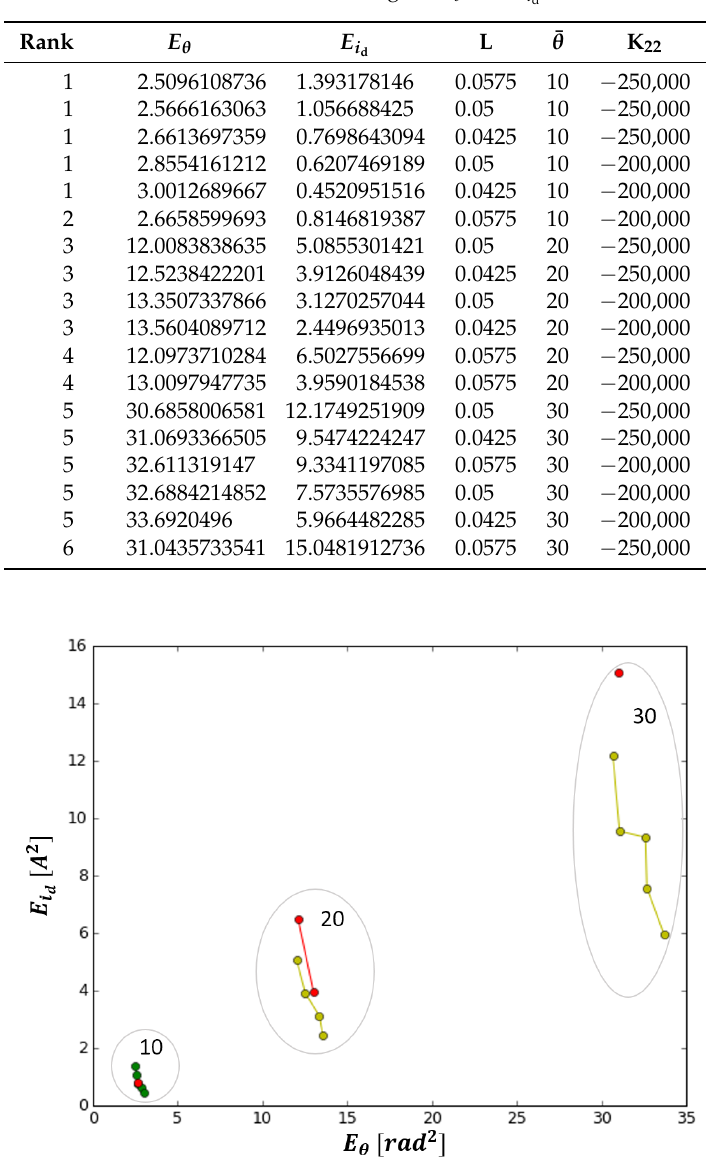
Figure 17. Pareto front for E θ and E i